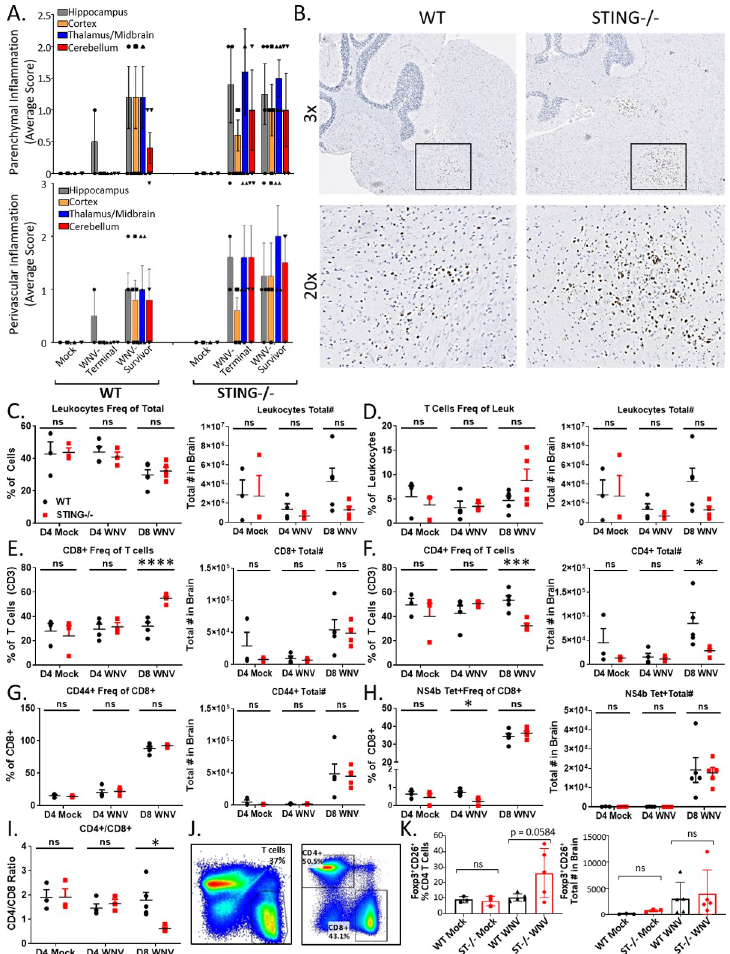
Fig 6. STING-/- have a defective adaptive immune response in the CNS during WNV infection. (A) Cellular infiltrate in the brain in Terminal and Survivor mice by pathological review of H&E. n = 3–5. (B) CD3 IHC of WNV infected brains. Boxed regions, higher magnification, lower panel. T cells stain brown; hematoxylin counterstain. (C-H) Flow analysis of brain lymphocytes. Left: frequency; Right: Absolute number. N = 3–5 per condition. Unpaired students t-test; p = 0.05 � ; p = 0.005 � ; p = 0.0005 ��� ). (I) CD4/CD8 ratio in the brain. (J) Flow gating scheme. (K) FoxP3+CD25+CD4 T cells in brains. Left: frequency; Right: Absolute number. N = 3–5 per condition.